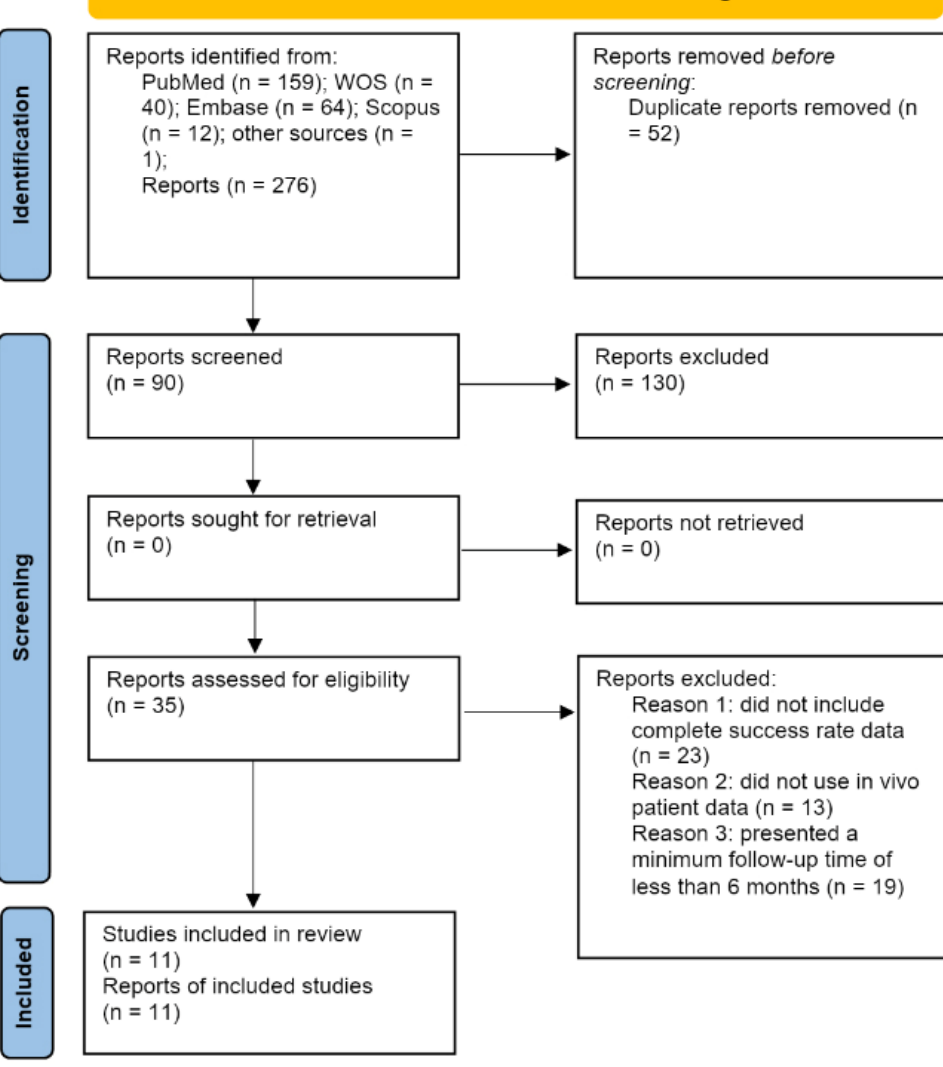
Figure 2. Preferred Reporting Items for Systematic Reviews and Meta-Analyses (PRISMA) flow diagram.